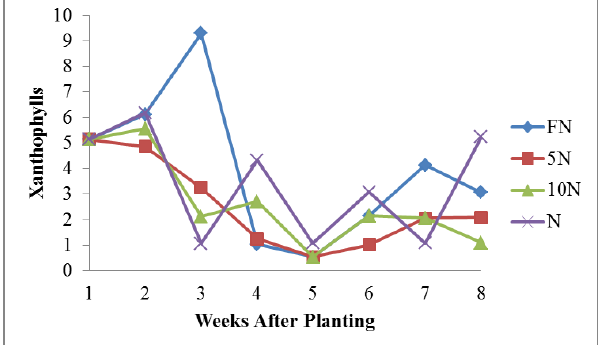
Fig. 4a. The effect of nitrogen nutritional stress on the carotene content of Vigna unguiculata measured at different periods